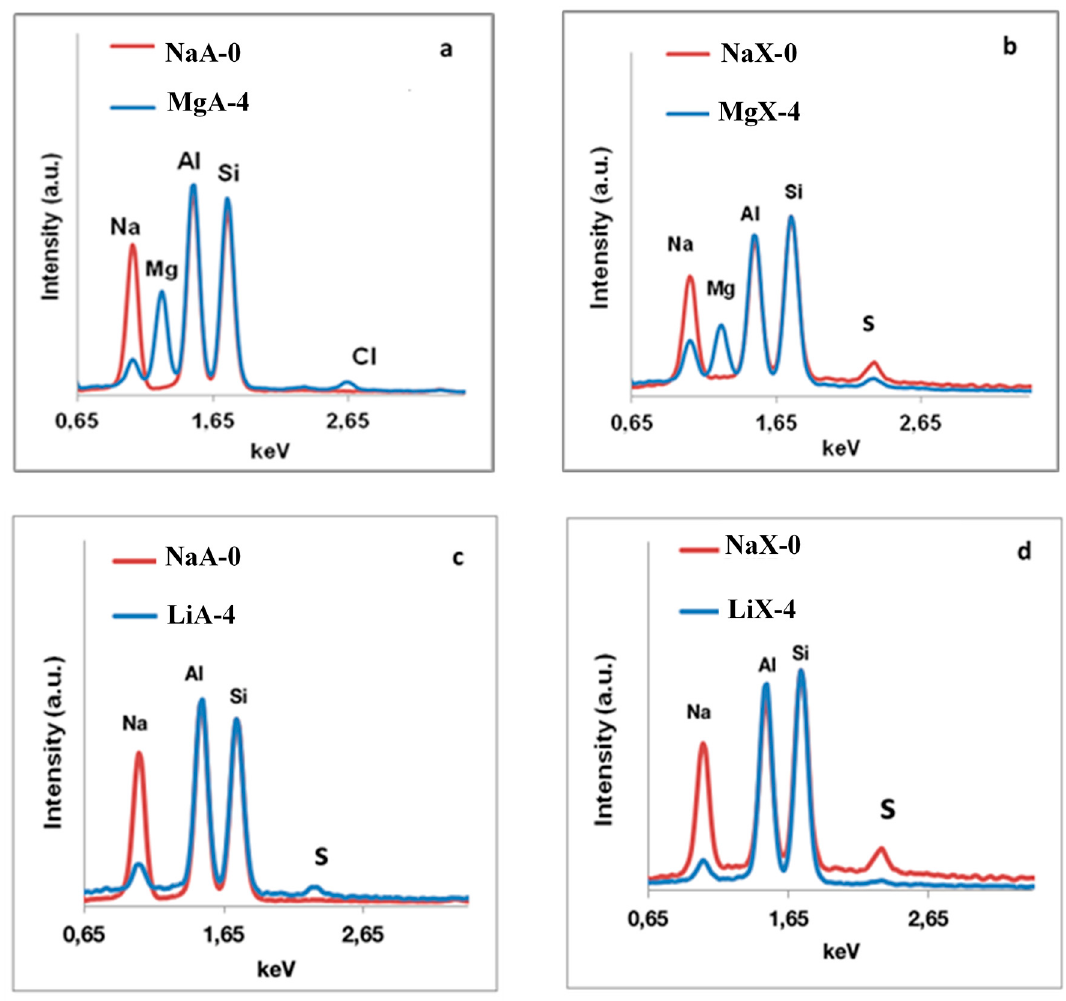
Figure A2. EDX spectra of ( a ) NaA-0 and MgA-4; ( b ) NaX-0 and MgX-4; ( c ) NaA-0 and LiA-4 and ( d ) NaX-0 and LiX-4 samples.